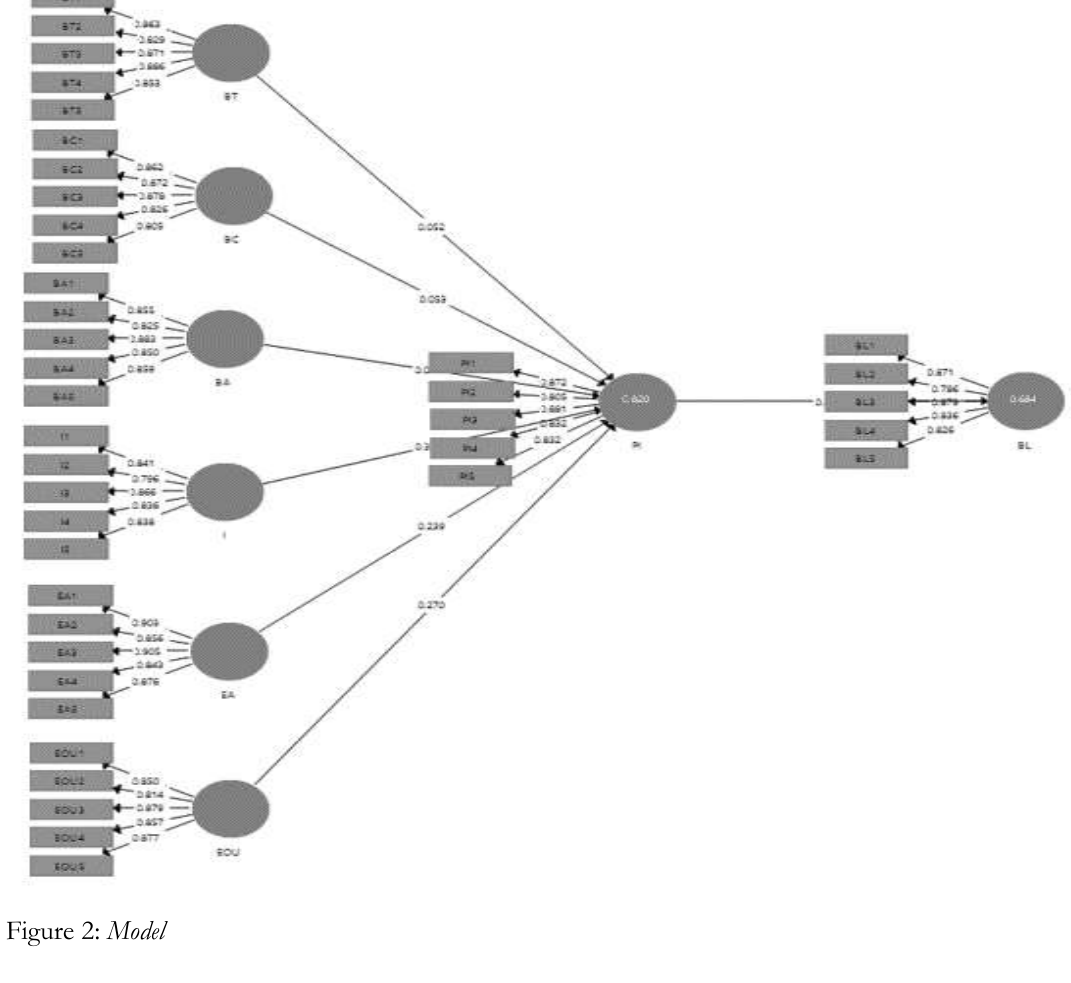
Table 2: Reliability and validity